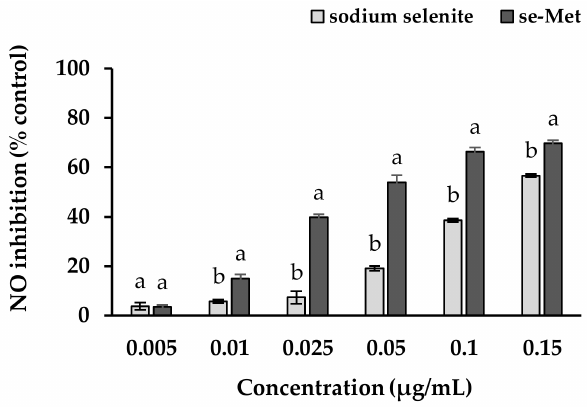
Figure 8. The effect of extracts on the inhibition of nitric oxide (NO) in RAW264.7 murine macrophage cells after co-incubation of LPS from E. coli (0.5 µ g/mL) with sodium selenite, seleno-methionine (se-Met) from Se-yeast for 24 h. Data are means ± standard deviation (SD). Different letters indicate significant differences ( p < 0.05) in Duncan’s significant differences